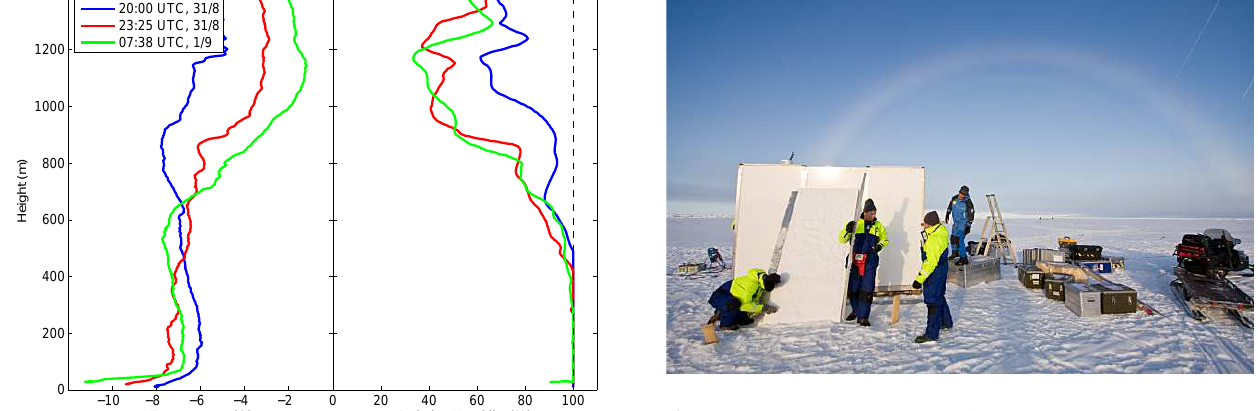
Fig. 5. A rare case of a double fog bow observed on 31 August